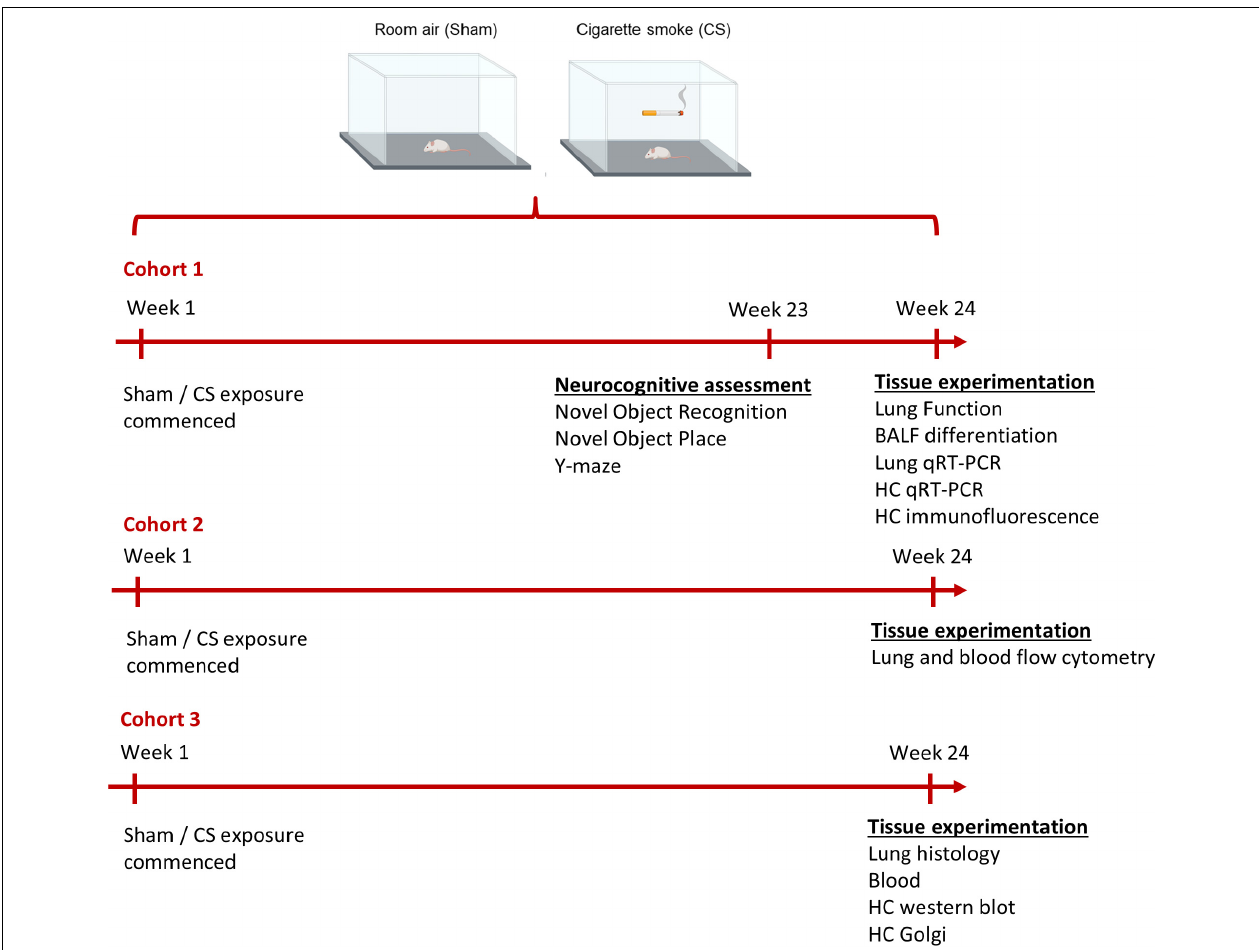
FIGURE 1 | Timeline of experimental design. Mice were exposed to room air (sham) or cigarette smoke (CS; 9 cigarettes/day, 5 days/week) for 24 weeks. Cohort 1: neurocognitive assessments were performed on mice a week prior to protocol conclusion (week 23). Immediately prior to the cull, lung function assessment was performed (week 24). To examine the inflammatory profile within the lungs and hippocampus, we collected bronchoalveolar lavage (BAL) fluid for BAL differentiation and dissected the lungs and left hippocampi for qPCR. The right hippocampi was dissected for immunofluorescence. Cohort 2: lung and cardiac blood from a separate cohort of mice was collected for flow cytometric analysis. Cohort 3: a separate cohort was culled to examine lung pathology, blood brain barrier integrity (left hippocampi), and hippocampal dendritic spines (right